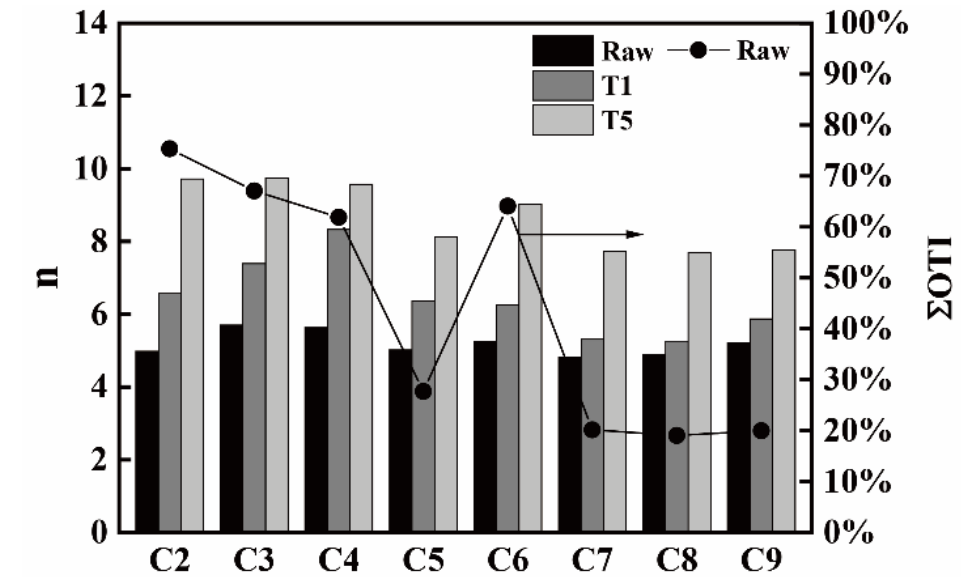
Figure 9. The n and Σ OTI (raw coke) values for all the cokes.